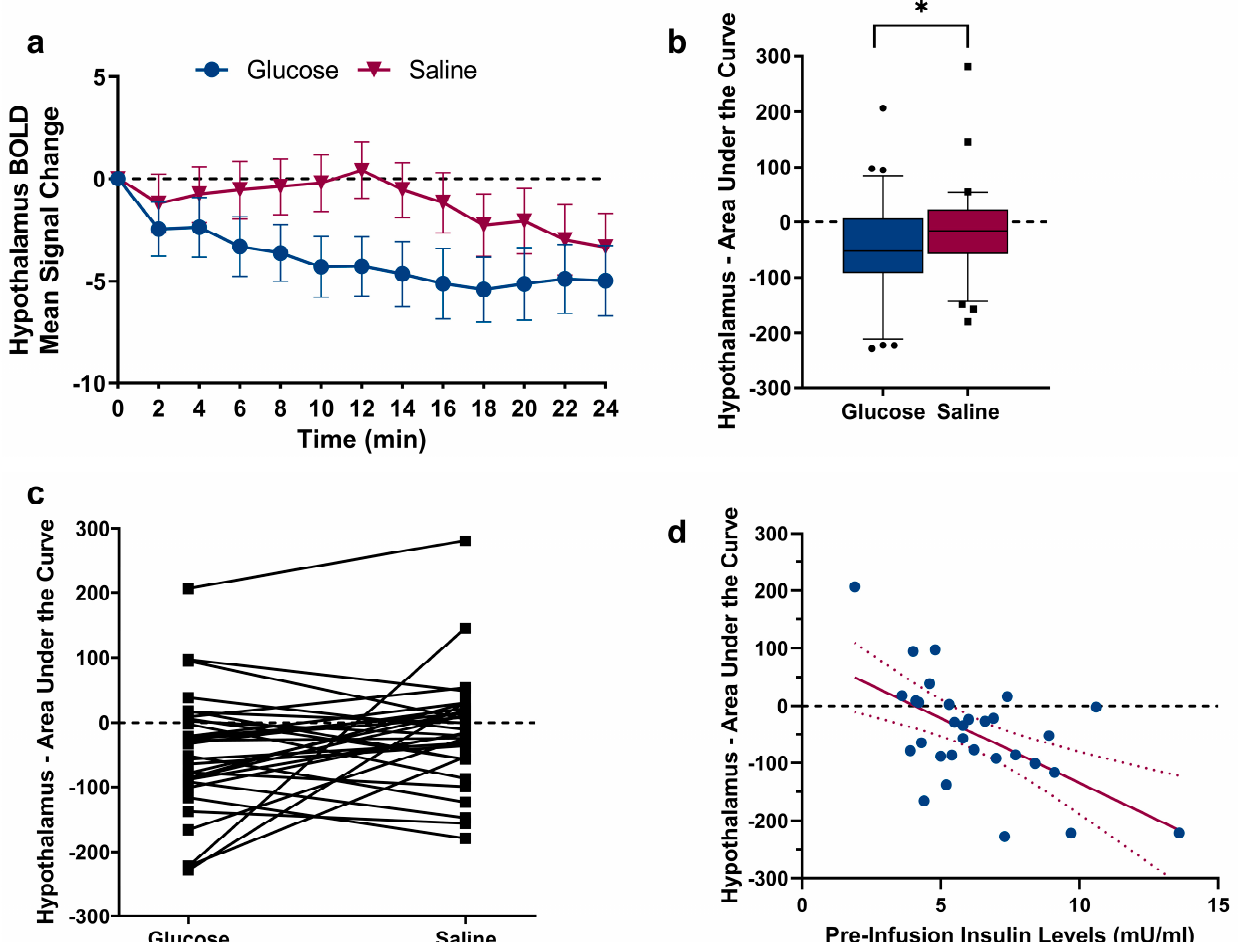
Figure 2. ( a ) BOLD signal change in the hypothalamus Region-Of-Interest (manually segmented on individual native space brain scans) following glucose and saline infusion over time. ( b ) A comparison of the AUC revealed significant differences between glucose and saline (t 30 = 1.88, p = 0.035). * p ≤ 0.05, paired Student’s t -test. Individual data points above and below the 10th and 90th percentiles are shown as squares and dots. ( c ) Data points for each participant plotted with lines showing the difference in AUC between glucose and saline infusion. ( d ) Negative correlation between blood plasma insulin levels assessed before MRI scanning and hypothalamic AUC following glucose injection (r = − 0.579, p < 0.001), Pearson product-moment correlation coefficient (2-tailed). Regression line is depicted with 95% confidence bands.